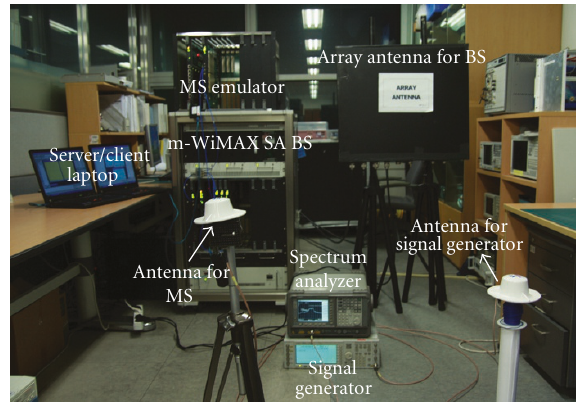
Figure 10: Photograph of experimental environment.